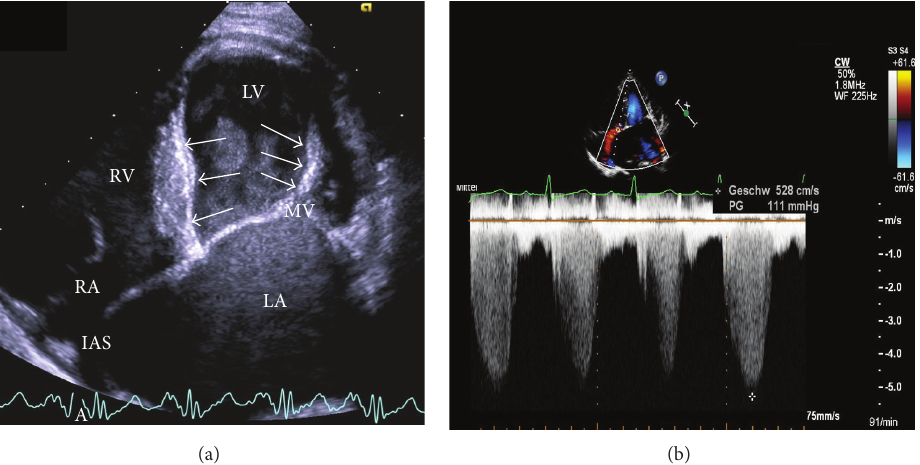
Figure 1: Echocardiography: 4-chamber view showing extremely enlarged left atrium (LA) and endocardial fibroelastosis (arrows) of left ventricle (LV) and mitral valve apparatus (a). Doppler maximum velocity of tricuspid insufficiency before initiation of medical therapy, indicating high systolic RV pressure of 111mmHg (b). RV = right ventricle; RA = right atrium; IAS = interatrial septum.